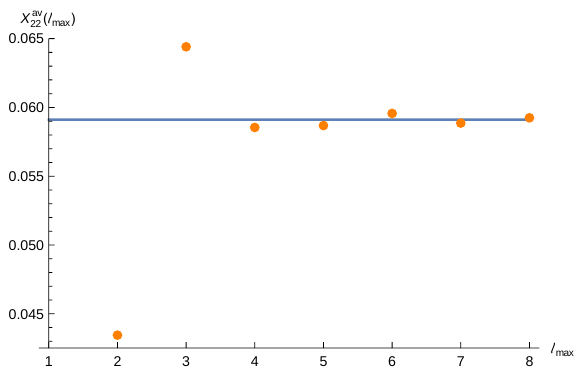
Figure 3 . Orange dots show X av horizontal line at 0 : 0591147 represents X KZ